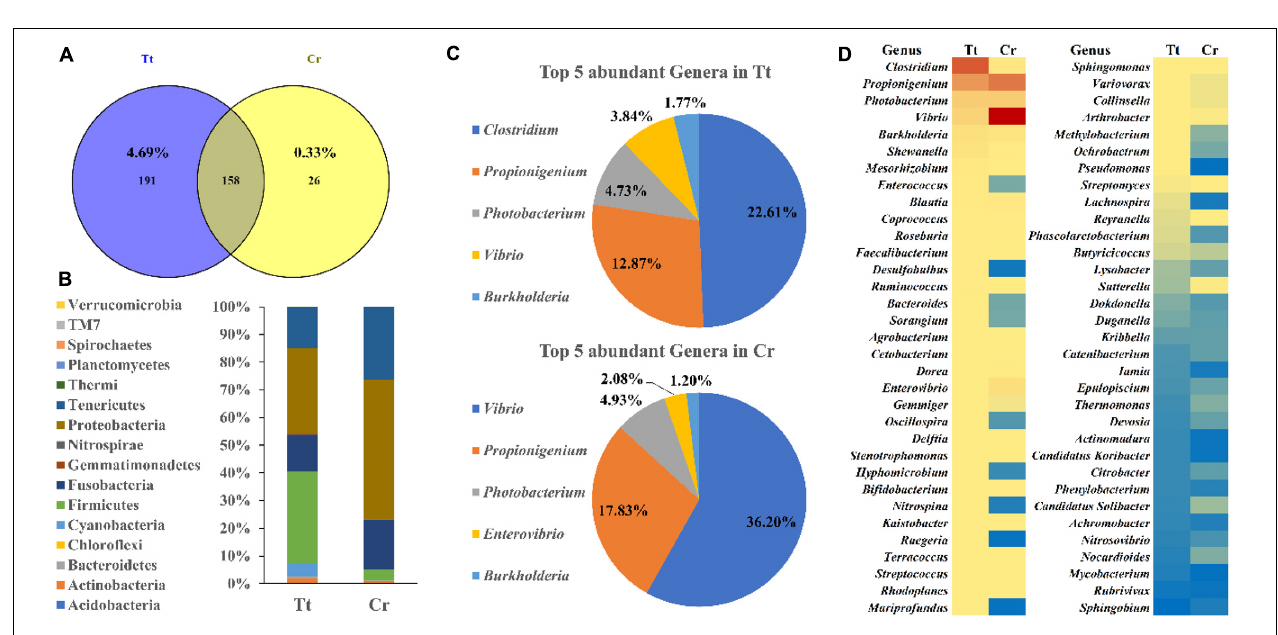
FIGURE 3 | Protein domains of identified sodium channels in panels (A) C. rotundicauda , (B) T. tridentatus and (C) Tetrodotoxin-resistant related site replacements. Sequences used in the alignment: Takifugu rubripes Nav1.4a channel (ABB29441); Takifugu rubripes Nav1.4b channel (ABB29442); Tetraodon nigroviridis Nav1.4a channel (ABB29443); Tetraodon nigroviridis Nav1.4b channel (ABB29444); Danio rerio Nav1.4a channel (ABB29445); Danio rerio Nav1.4b channel (ABB29446); Homo sapiens skeletal muscle Nav1.4 channel (P35499); Homo sapiens cardiac Nav1.5 channel (Q14524) and Thamnophis sirtalis skeletal muscle Nav1.4 (AAW68224).